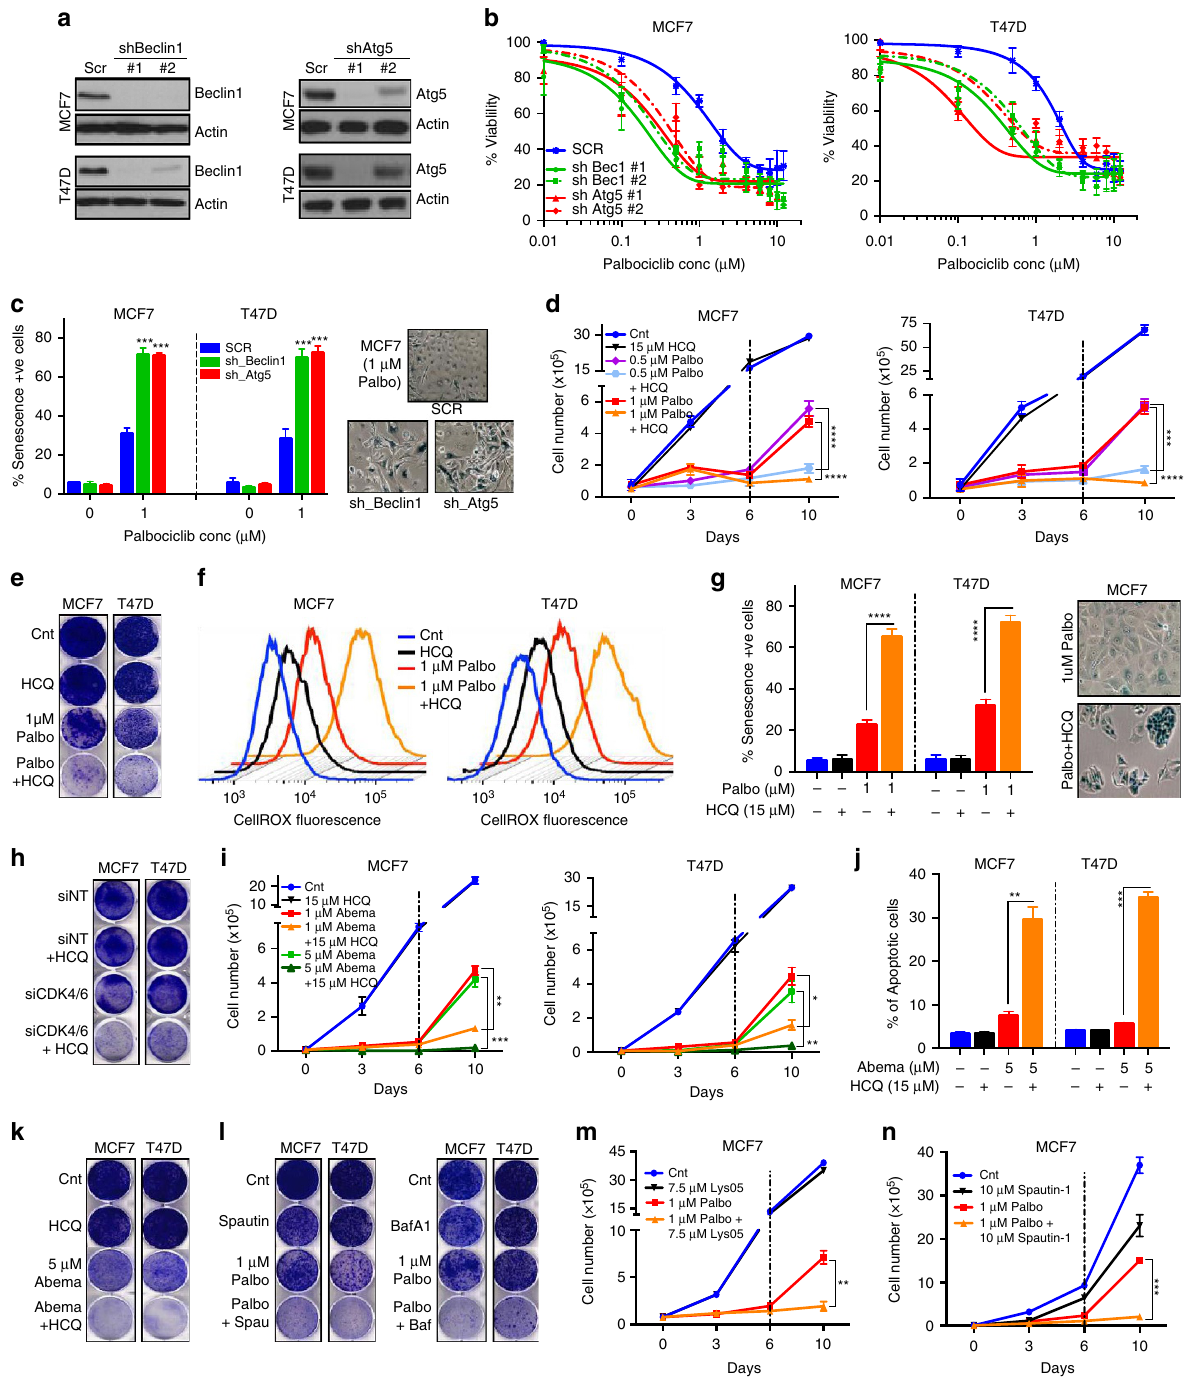
Figure 2 | Autophagy inhibition sensitizes cells to CDK4/6 inhibition. ( a ) Western blot for Beclin-1 and Atg-5 in MCF7 and T47D cells after transfection with Scrambled (Scr), Beclin-1 or Atg5 shRNA. MCF7 and T47D cells with Beclin-1 or Atg5 knocked down were treated with palbociclib for 6 days and subjected to ( b ) dose–response assay after 6 days of recovery and ( c ) SA- (cid:2) galactosidase measurement. P values calculated in comparison with SCR (cid:2) 1 m M palbociclib. MCF7 and T47D cells were treated with combination of palbociclib and 15 m M HCQ for 6 days. Cells were allowed to recover for 4 or 6 days in drug-free media and subjected to ( d ) Cell counting, ( e ) clonogenic assay, ( f ) cellular ROS measurement and ( g ) SA- (cid:2) galactosidase measurement. ( h ) Clonogenic assay to measure impact of combined siRNA against CDK4/6 and treatment with 15 m M HCQ for 6 days. MCF7 and T47D cells were treated with 5 m M abemaciclib combined with 15 m M HCQ for 6 days and recovery for 4 or 6 days and subjected to ( i ) cell counting ( j ) measurement of total apoptotic cells (early apoptosis: Annexin V þ /propidium iodide (cid:2) and late apoptosis: Annexin V þ /propidium iodide þ ) and ( k ) clonogenic assay. ( l ) Clonogenic assay in MCF7 and T47D cells treated with 10 m M spautin-1 or 1nM bafilomycin A1 (Baf-A1) combined with 1 m M palbociclib for 6 days and recovery for 6 days. ( m , n ) Cell counting to assess growth of cells treated with 1 m M palbociclib and 7.5 m M Lys-05 ( m ) or 10 m M Spautin-1 ( n ) for 6 days and recovery for 4 days. All data represent mean ± s.d. from three independent experiments; NS: P 4 0.05; * P o 0.05; ** P o 0.01; *** P o 0.001; **** P o